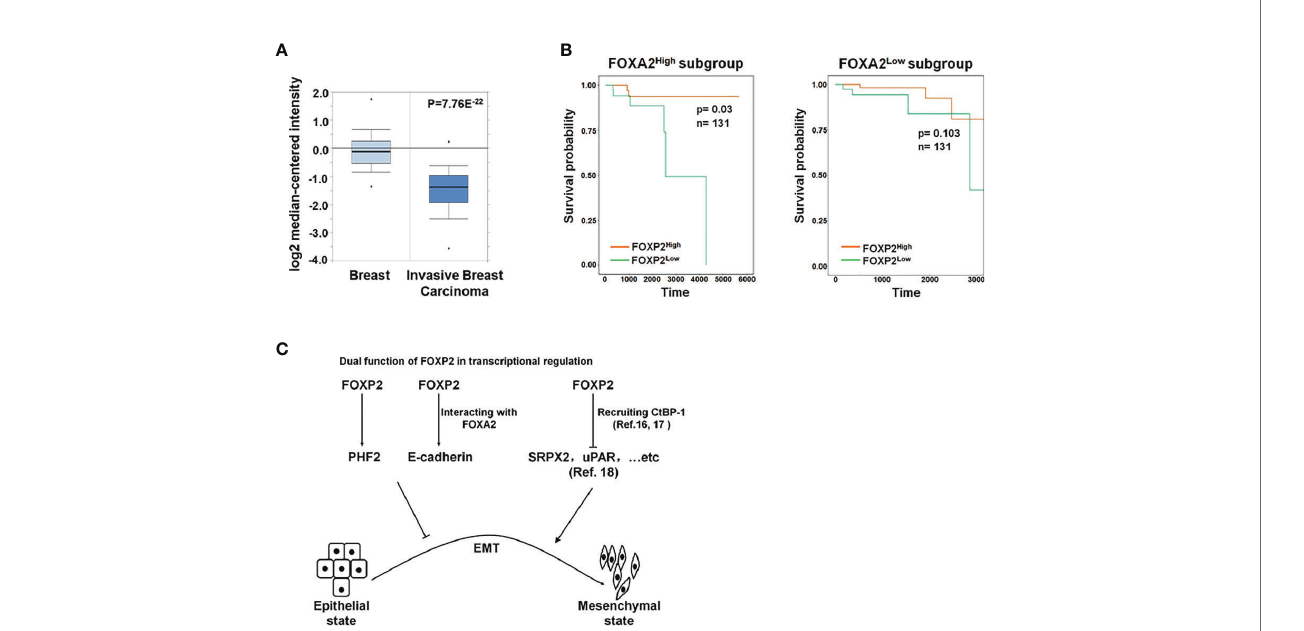
FIGURE 6 | The roles of FOXP2 in EMT of breast cancer cells. (A) The Oncomine boxplots of FOXP2 levels were analyzed between invasive breast tissues and normal breast tissues from the oncomine.org website. The p-value of the TCGA RNA-seq data of normal breast samples (n=61) versus invasive breast carcinoma samples (n=76) was 7.76E -22 . (B) The FOXP2-improved survival in breast cancer patients relied on the participation of FOXA2. The FOXA2 High subgroup (n=131) or the FOXA2 Low subgroup (n=131) contained either the top 1/3 or the bottom 1/3 of the collected BRCA data set (n=394), respectively. FOXP2-related survival of patients in the FOXA2 High and FOXA2 Low subgroups was fi tted by the “ surv fi t ” function, and Kaplan – Meier curves were drawn by the “ ggsurv ” function in the R package “ survival ” . (C) The roles of FOXP2 in epithelial-mesenchymal transition (EMT) of breast cancer cells. FOXP2 prevented EMT of breast cancer cells by regulating the transcription of multiple EMT-related genes: FOXP2 could bind to certain promoters and stimulate the transcription of genes such as PHF2 and E- cadherin. The transcriptional activation by FOXP2 could be mediated by FOXA2. FOXP2 could also repress the transcription of certain genes such as SRPX2 and uPAR, through recruiting co-repressors such as